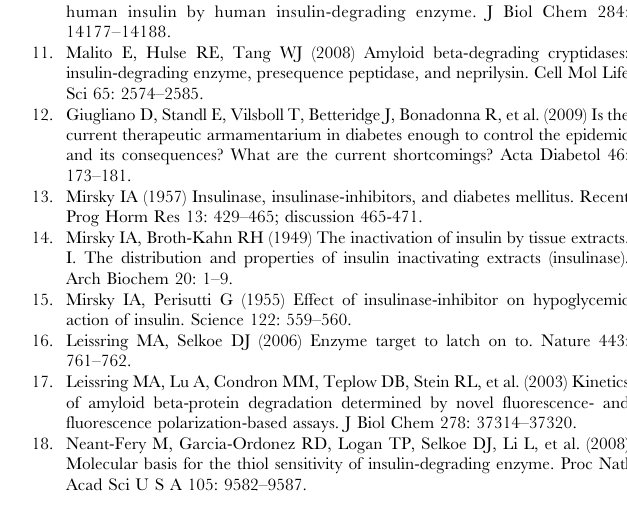
Figure S9 Synthetic scheme for generation of diaster- eomerically pure conventional peptide hydroxamic acids. a ) t-BuONH2Aˆ ? HCl, HBTU, DIPEA; b ) LiOH then HCl. Note that these experiments were conducted to confirm the stereochemistry assignments made for each diastereomer 18a , 18b , 19a , and 19b (see Fig. S8). Figure S10 Alternate synthetic scheme for generation of conventional peptide hydroxamic acids. a) t-BuONH 2 ? HCl, HBTU, DIPEA; b) LiOH then HCl; c) EtO 2 CCl, Et3N, 2 78 u C then NH 2 -Arg(Pbf)-allyl ? HCl. General Procedure for the Prepara- tion of Protected Hydroxamates 21 and 23 The protected hydroxamate 21 obtained as a colorless oil (290 mg, 88%) starting from (R)-acid 20 following the general procedure described for 6a and 6b . Also 23 was obtained as a colorless oil (485 mg, 94%)